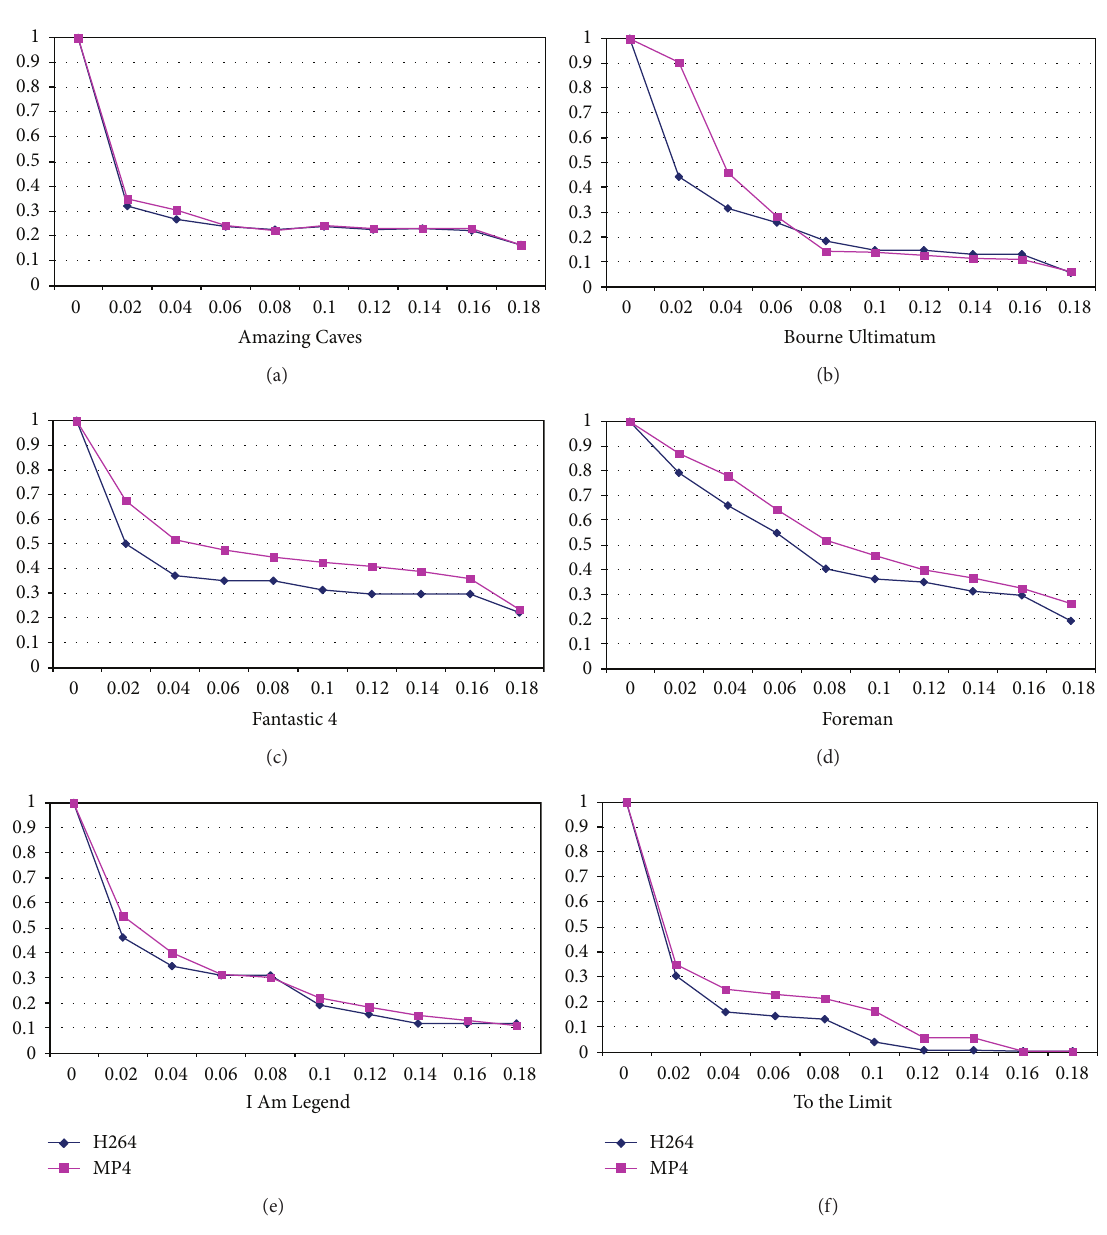
Figure 10: Ratio between decoded layers and sent layers (based on